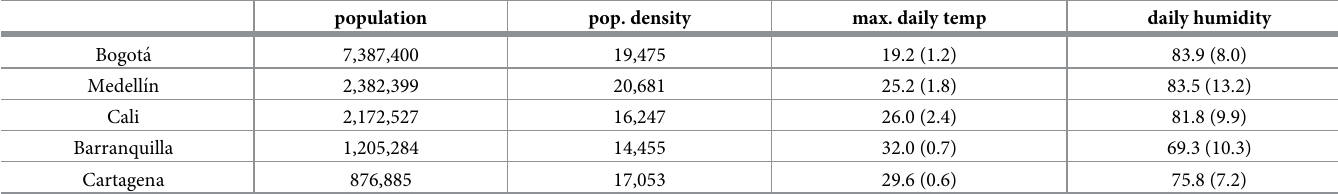
The temperature shown is the mean maximum daily temperature over the period of the study. In parentheses, the variation from the mean (the standard deviation) is shown. Our analysis found that the mean maximum daily temperature is an important proxy for the heat transmission barrier. The small variations demonstrate the constant weather patterns within each city studied as pertains to our model of SARS-CoV-2 transmission. The humidity is the mean daily relative humidity over the period of the study (standard deviation in parentheses). The population density is the urban population